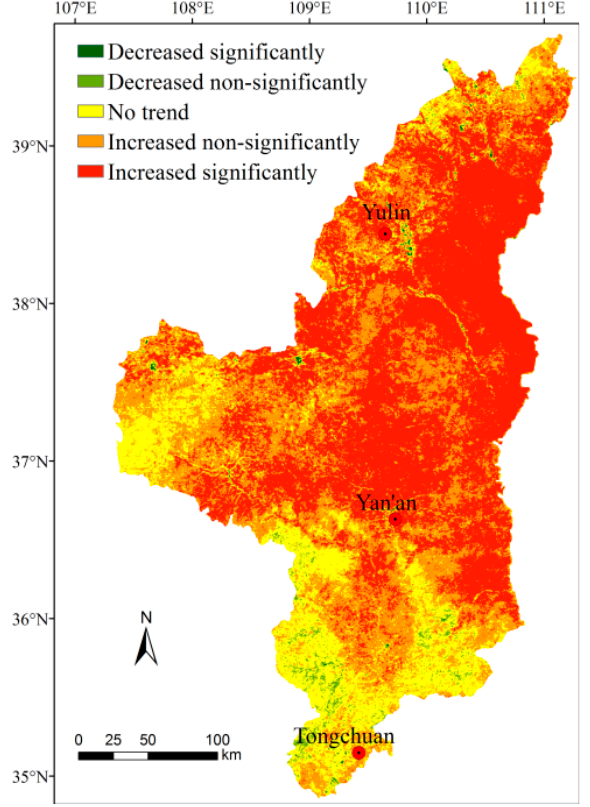
Figure 5. Spatial distribution of the change trend in annual GPP during 2000–2012.